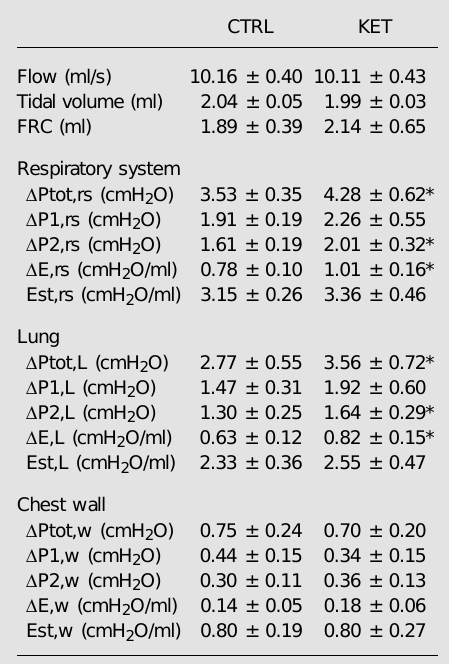
Table 1. Respiratory data of rats anesthetized with pentobarbital sodium or ketamine. CTRL